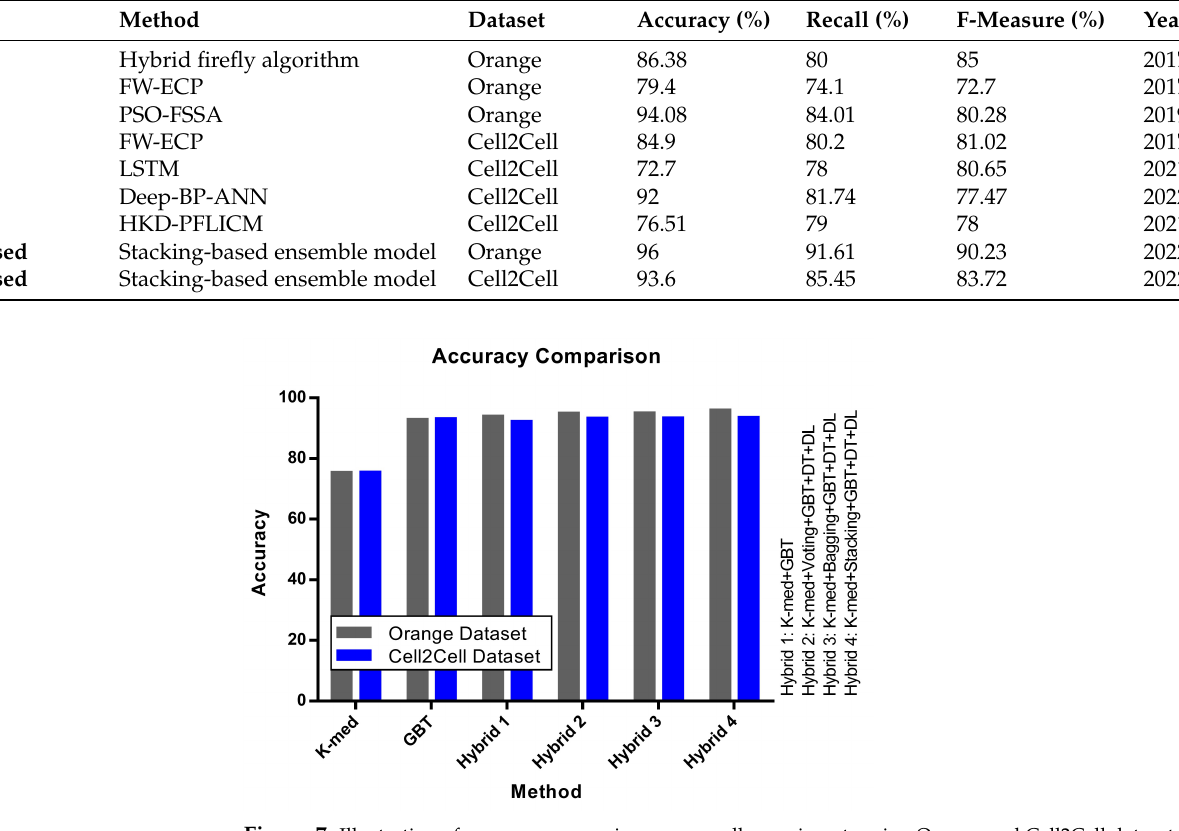
Figure 7. Illustration of accuracy comparison among all experiments using Orange and Cell2Cell